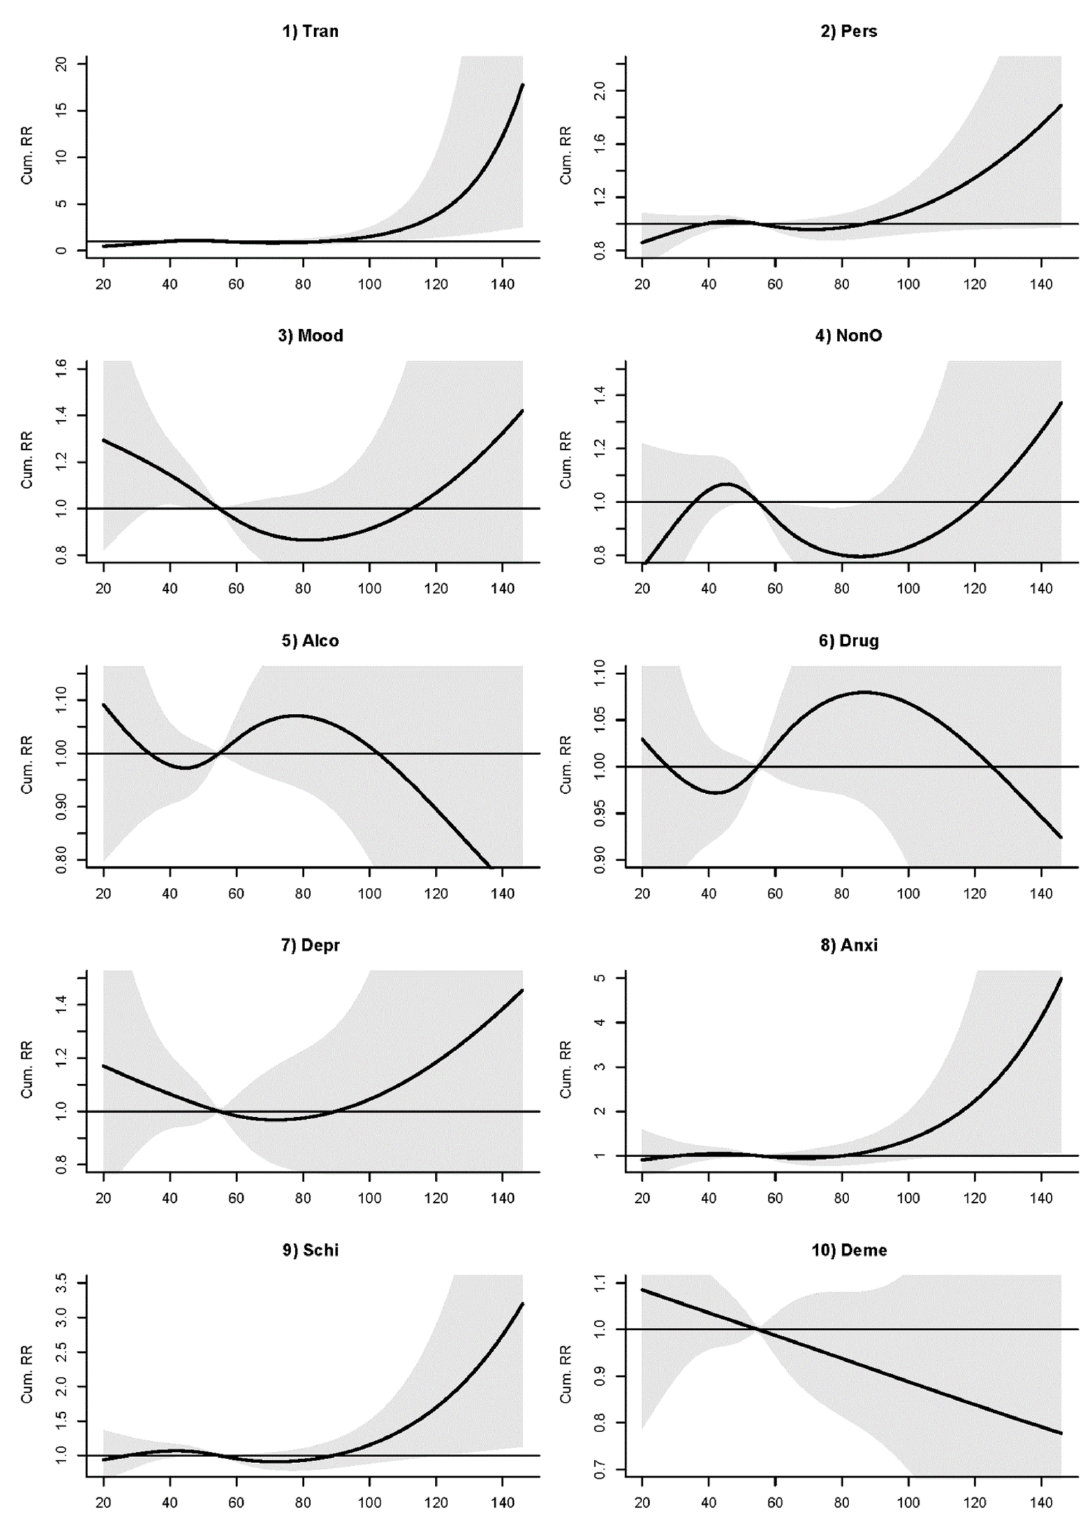
Figure A2. RR-NO2 ( µ g/m 3 ) plots of mental disorder admissions in lagged 0–8 days for ( 1 ) transient mental disorders (Tran), ( 2 ) persistent mental disorders (Pers) , ( 3 ) episodic mood disorders (Mood), ( 4 ) other nonorganic psychoses (NonO), ( 5 ) alcohol-related mental disorders (Alco), ( 6 ) drug-related mental disorders (Drug), ( 7 ) depressive disorder (Depr), ( 8 ) anxiety, dissociative and somatoform disorders (Anxi), ( 9 ) schizophrenic disorders (Schi) and ( 10 ) dementias admissions (Deme) in Hong Kong,